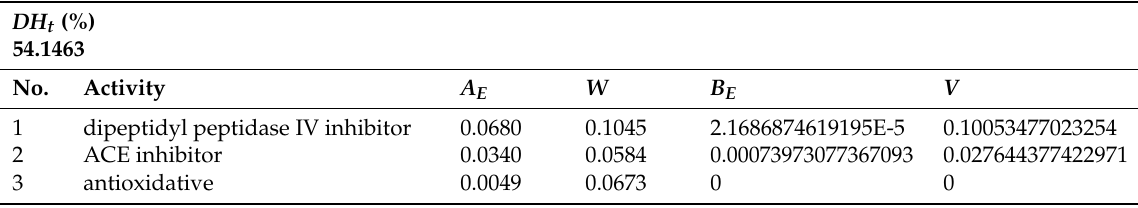
Table A38. A E , DH t , W , B E and V values from RubisCO of Halophila stipulacea . In silico enzymatic cleavage was carried out by using stem